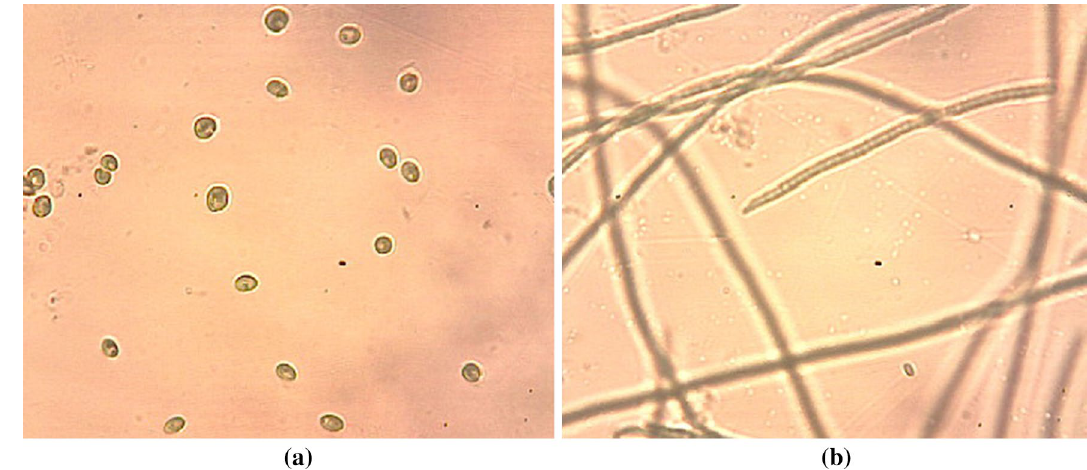
Fig. 1 Morphological appearance of a Chlorella sp. SRD3 and b Oscillatoria sp.